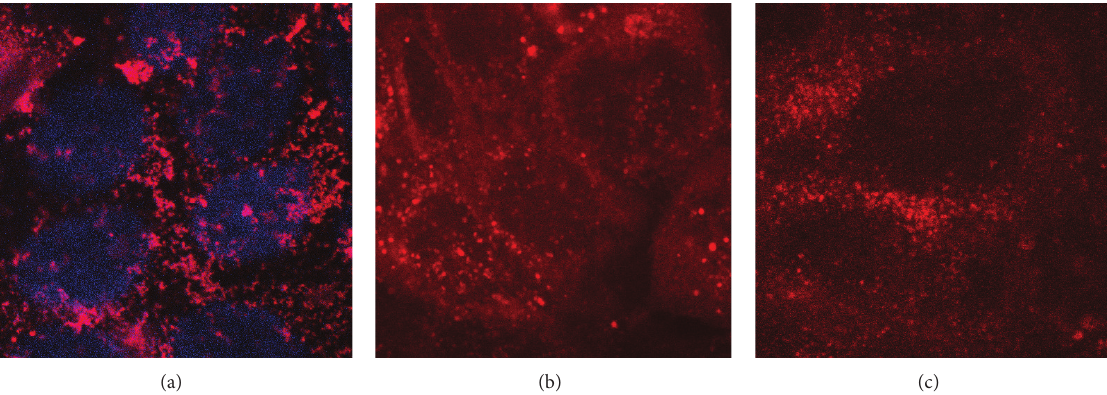
Figure 4: HaCaT cells stained by conjugate “Chitosan-PFD” (conc. 2.2 mg/mL) (a), the mixture of PFD (conc. 5 𝜇 g/mL) and chitosan (2.2 𝜇 g/mL) (b), and PFD-NHS (conc. 5 𝜇 g/mL) and chitosan (2.2 𝜇 g/mL) (c) after photoactivation (image dimensions, 36 by 36 𝜇